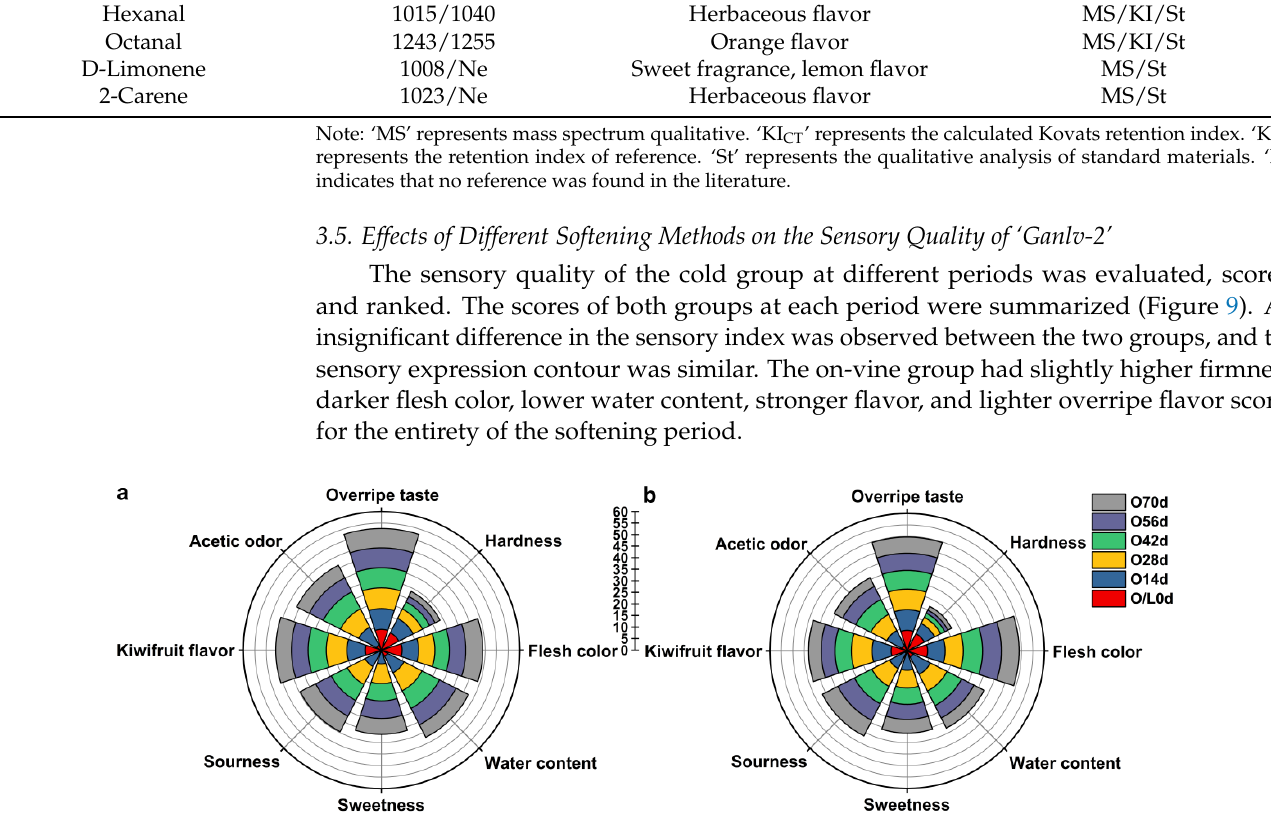
Figure 9. Results of the sensory evaluation. ( a ) On-vine group. ( b ) Cold group. The final score is the sum of the average scores of all organoleptic properties.